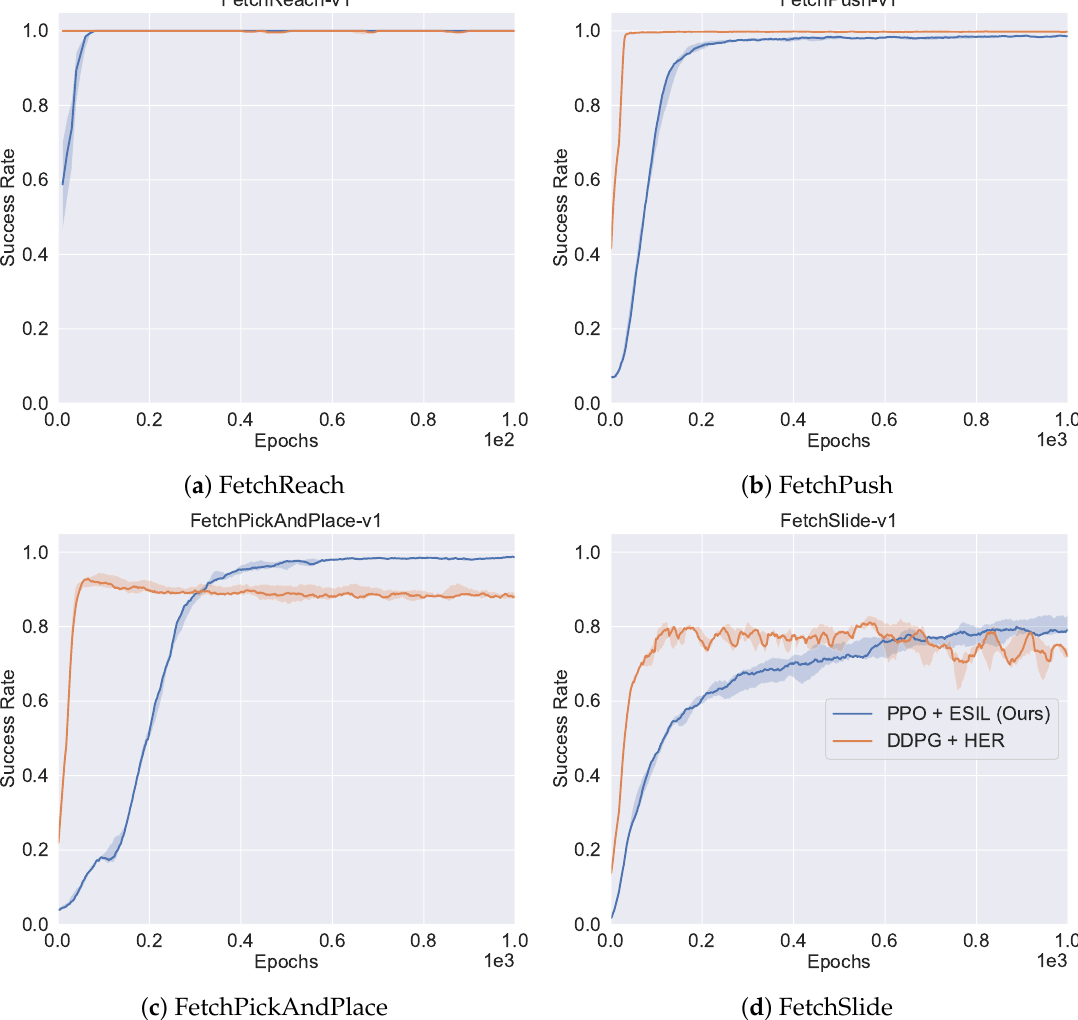
Figure 8. Results of comparison between PPO+ESIL and DDPG+HER on all Fetch